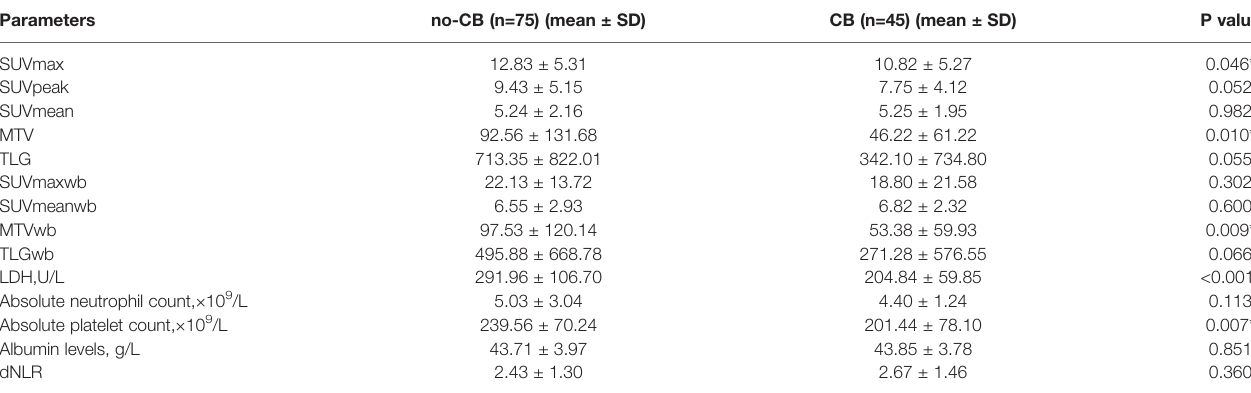
TABLE 2 | Independent sample student t-test of groups difference (CB vs